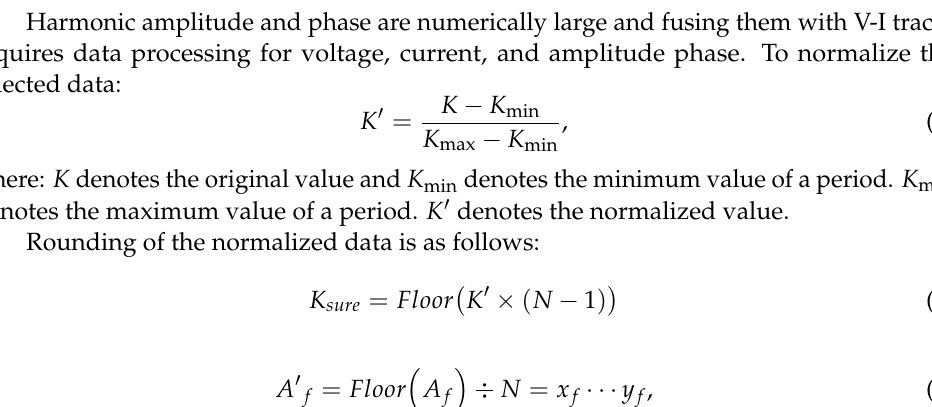
( b ) Figure 5. ( a ) Standard network structure diagram. ( b ) ResNet structure diagram. The principle of ResNet is: